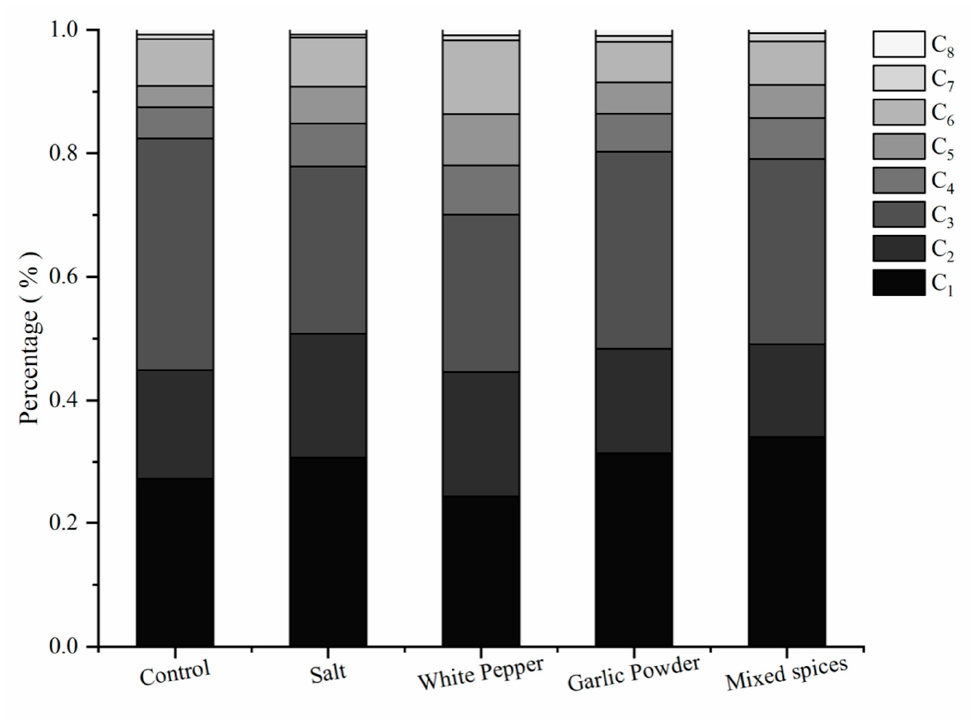
Figure 3. The relative proportions of C 1–8 aldehyde and ketone compounds emitted from the grilling.